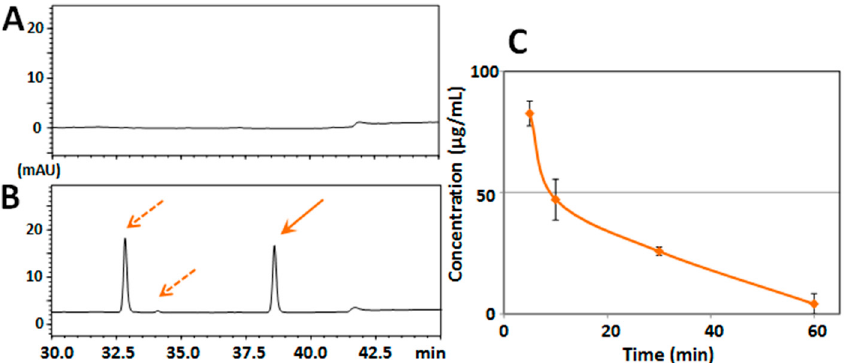
Figure 2. ( A ) HPLC chromatograms of serum from vehicle-treated mouse; and ( B ) HPLC chromatograms of serum from mice treated intraperitoneally (i.p.) with HMF. Solid arrow is HMF and dashed arrows are putative metabolites of HMF; ( C ) Time-course of the serum concentration profiles of HMF following i.p. administration. Values are the means ± SEM.